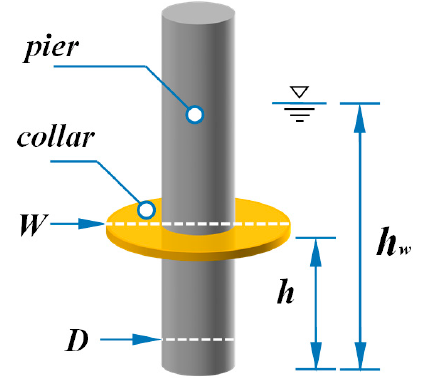
Figure 4. Schematic diagram of the collar model.